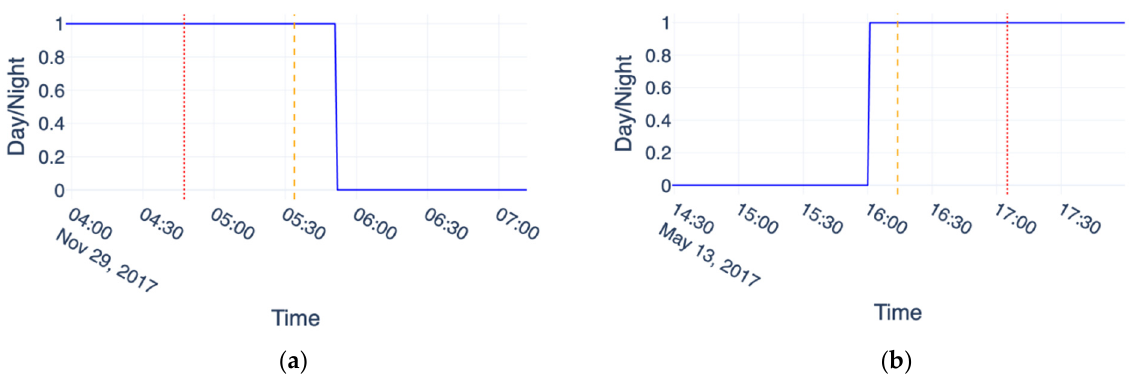
Figure 4. The results of images day/night clustering (blue line, 0—night, 1—day) in compare with: ( a ) sunset period (dotted line—sunset begin; dashed line—sunset end); ( b ) sunrise period (dashed line—sunrise begin, dotted line—sunrise end).